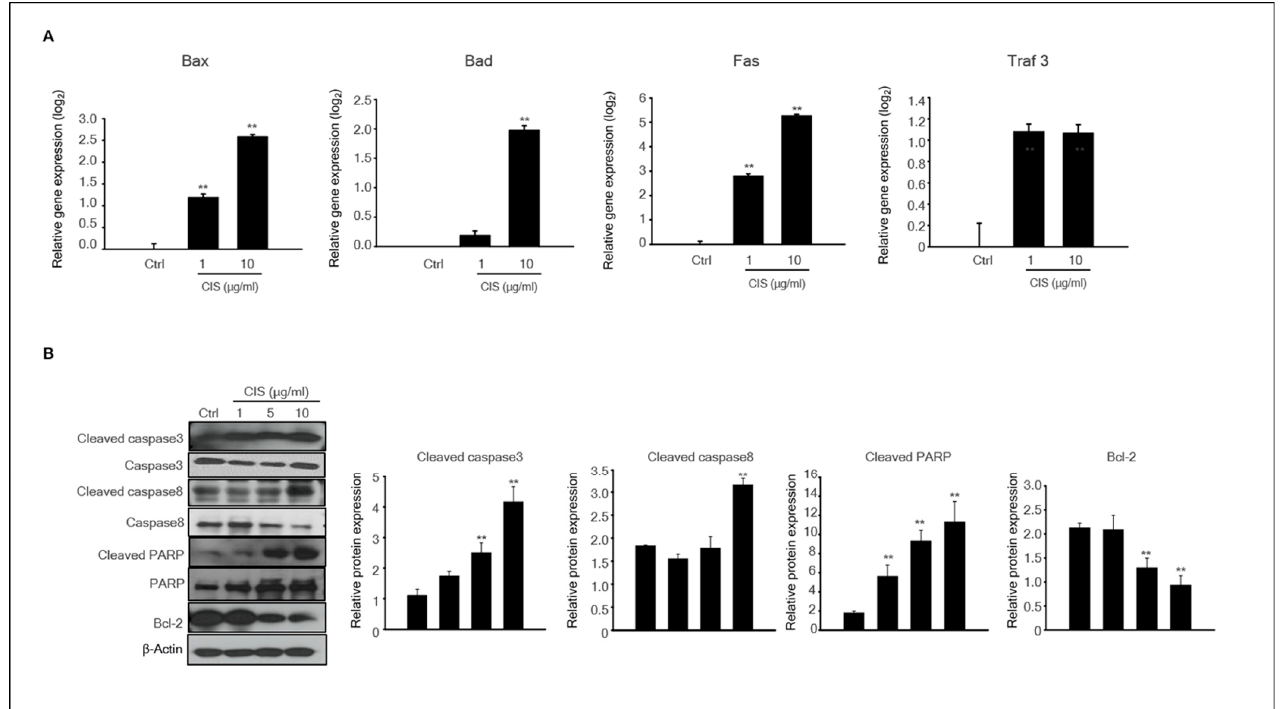
Figure 5. Expression of apoptosis-related genes and proteins in cisplatin-treated MTFs. ( A ) The expression levels of the apoptotic genes Bax, Bad, Fas, and Traf3 in the MTFs were determined by qPCR after treatments with 1 and 10 μ g/mL cisplatin. Data are represented as the mean and the standard error of the mean ( n = 5) at the log 2 scale. ** p < 0.01 ( B ) Pro-apoptotic proteins such as cleaved caspase-3, cleaved caspase-8, cleaved PARP, and Bcl-2 were detected in 0–10 μ g/mL cisplatin-treated MTFs by immunoblotting. β -actin was used as a loading control. Quantitative analysis of each protein level. Data are shown using the mean and the standard error of the mean ( n = 5), ** p < 0.01.